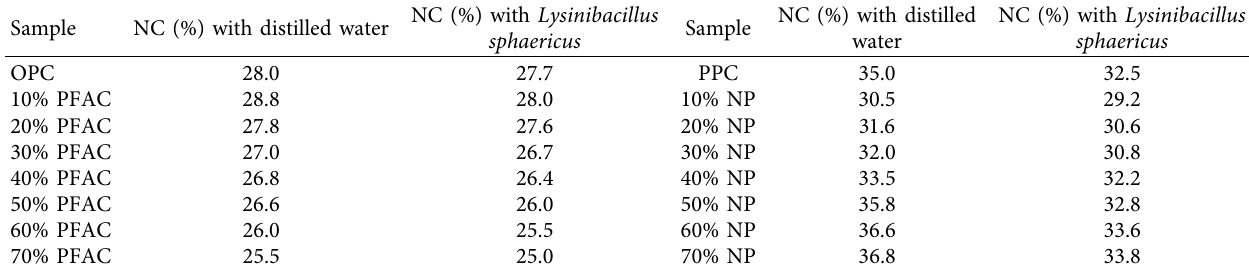
Table 3: Normal consistency (NC) for all categories of test samples.